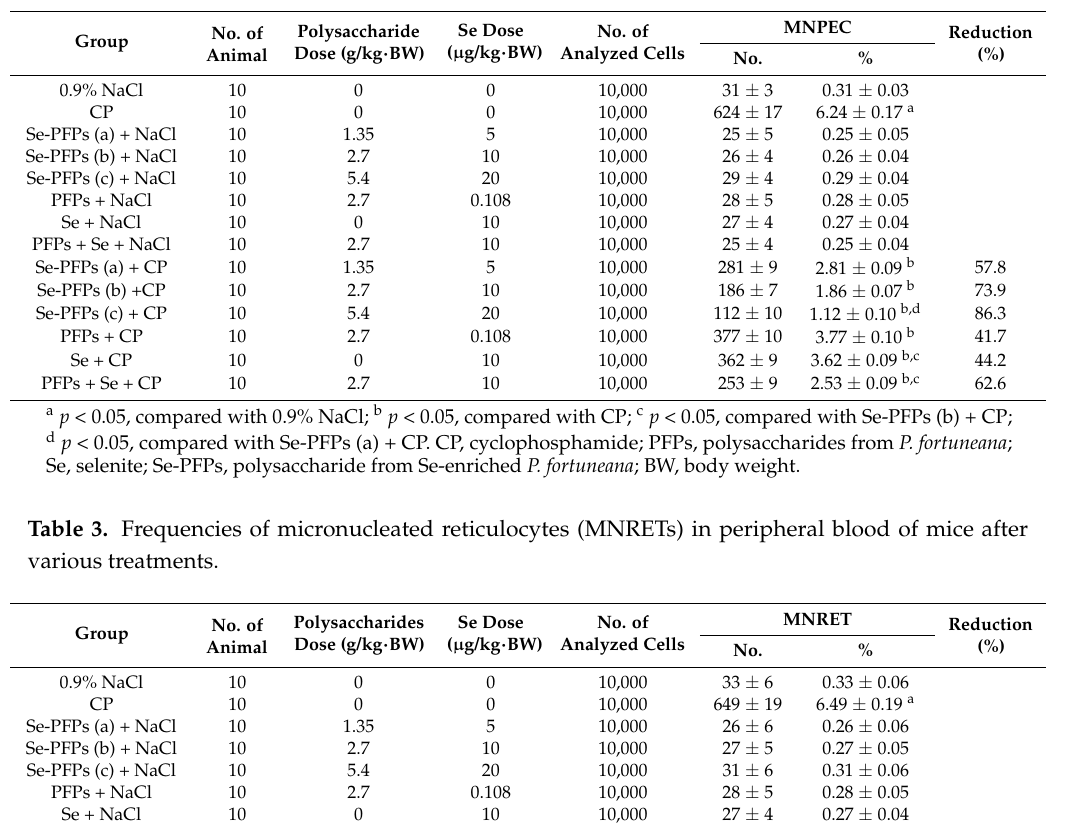
Table 2. Frequencies of micronucleated polychromatic erythrocytes (MNPECs) in bone marrow of mice after various treatments.